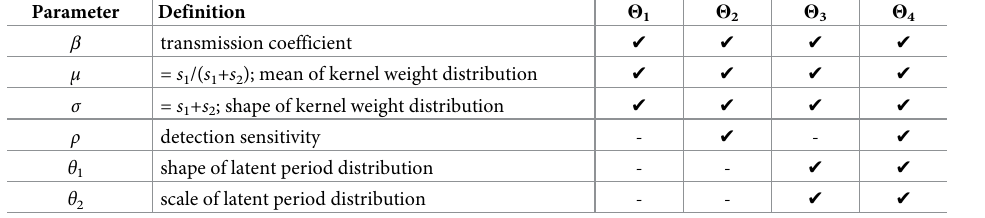
Table 2. Parameter sets for four estimation scenarios. Parameter